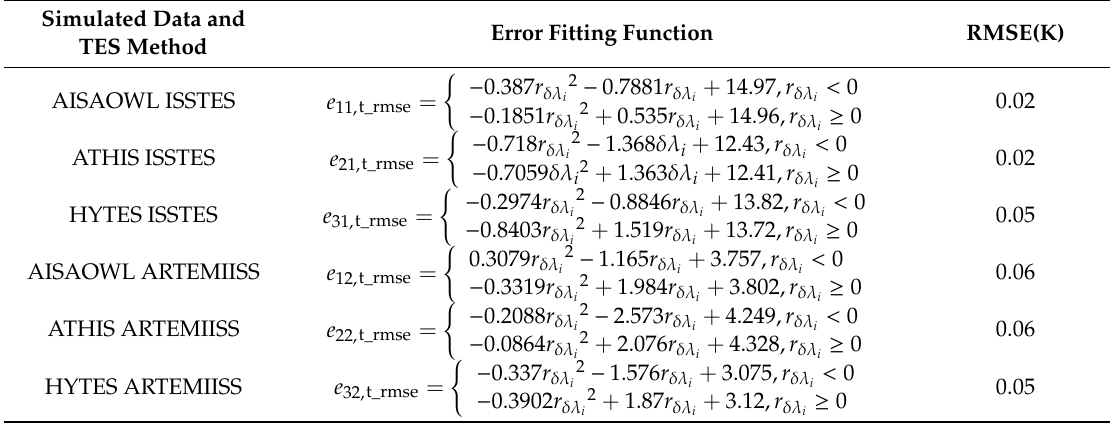
Table 3. The LST error fitting function about center wavelength shift ratio.